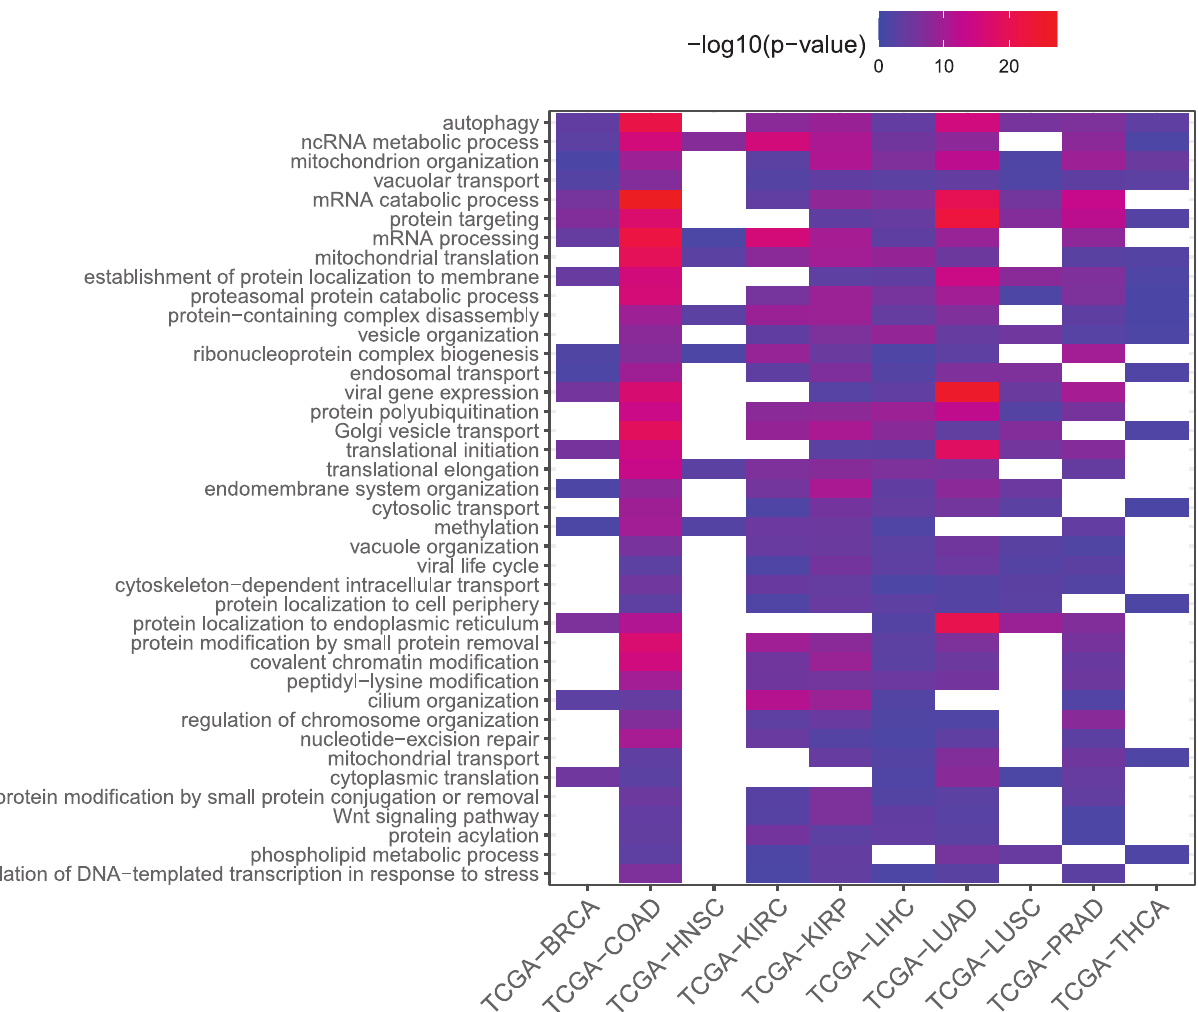
Fig 6. Enriched GO terms among overdispersed genes in tumors identified by the evaluated methods. Top 40 representative enriched Gene Ontology (GO) terms among overdispersed genes in tumors (DD+) among non-differentially expressed (non-DE) genes, ordered first by the number of datasets for which they are enriched (decreasing order) and second by the mean p-values of enrichment across all datasets (increasing order). Non-DE genes were identified using MDSeq, and DD+ genes were identified among non-differentially expressed genes by at least one of the evaluated methods, i.e . Levene’s test, MDSeq, DiPhiSeq, GAMLSS and DiffDist.